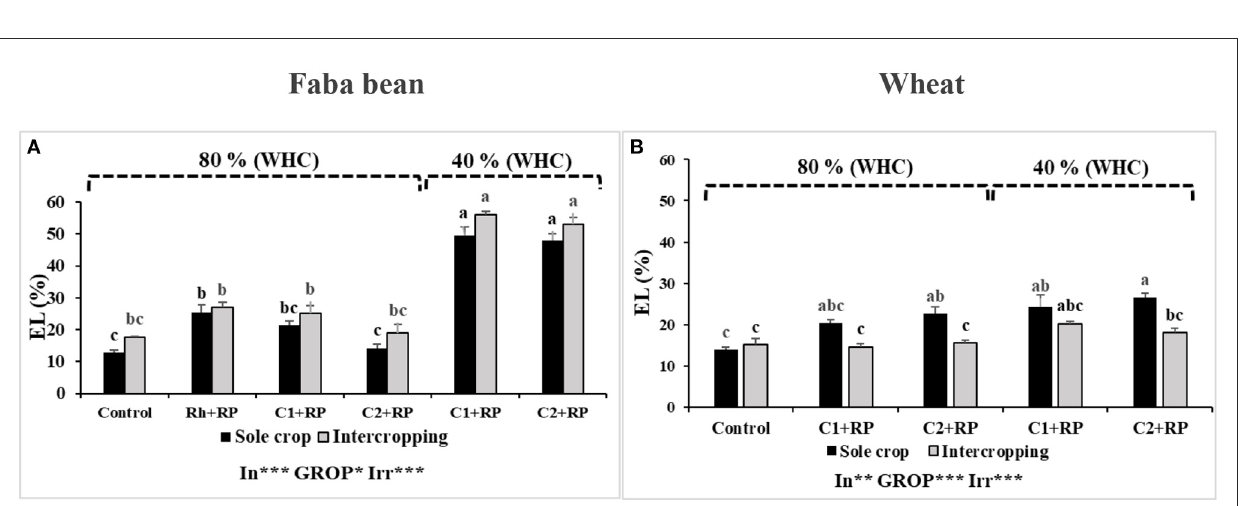
FIGURE2 Electrolyte leakage in faba bean (A) and wheat (B) grown as a sole crop or intercropped under water sufficiency and P limitation (80% WHC, RP) vs. combined water deficit and P limitation (40% WHC, RP) and inoculated with two rhizobacterial consortia (C1 and C2) containing rhizobia and two PGPRs. The positive controls were supplemented with 125 µ mol/l of KH 2 PO 4 and 46 mg/l of KNO 3 (control). The negative controls received RP and were inoculated with the rhizobia only (Rh + RP). Each value represents the mean ± standard error (SE) of three replicates (In, inoculation; GROP, type of cropping; Irr, irrigation). Values with different letters are significantly different at 0.05 level of probability by Student-Newman-Keuls. * Represent the significance level of treatments.